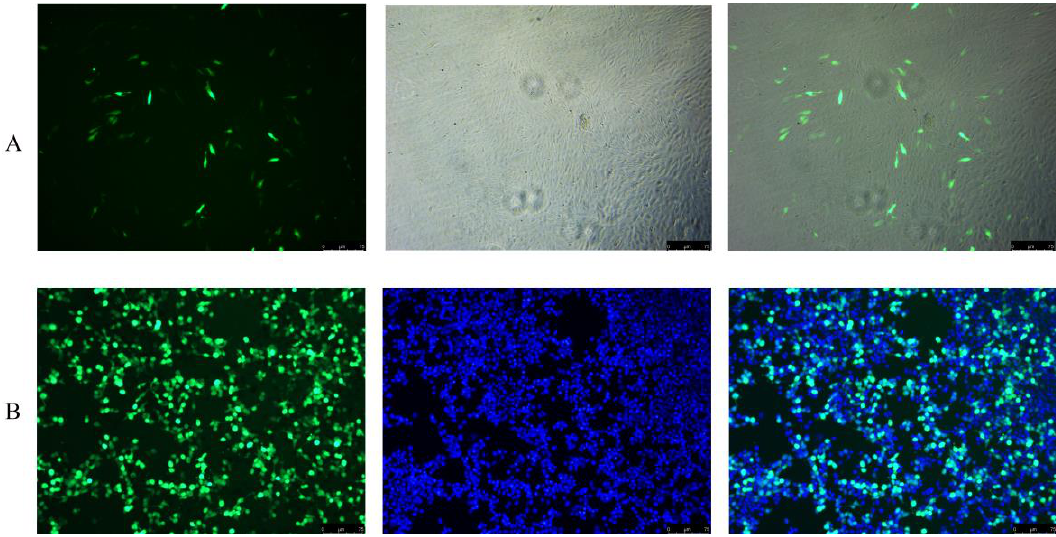
Figure 5. Expression of GFP reporter gene in TAH-11 cells and 293T cells: ( A ) TAH-11; ( B ) 293T cells. Scale bar = 75 μm.